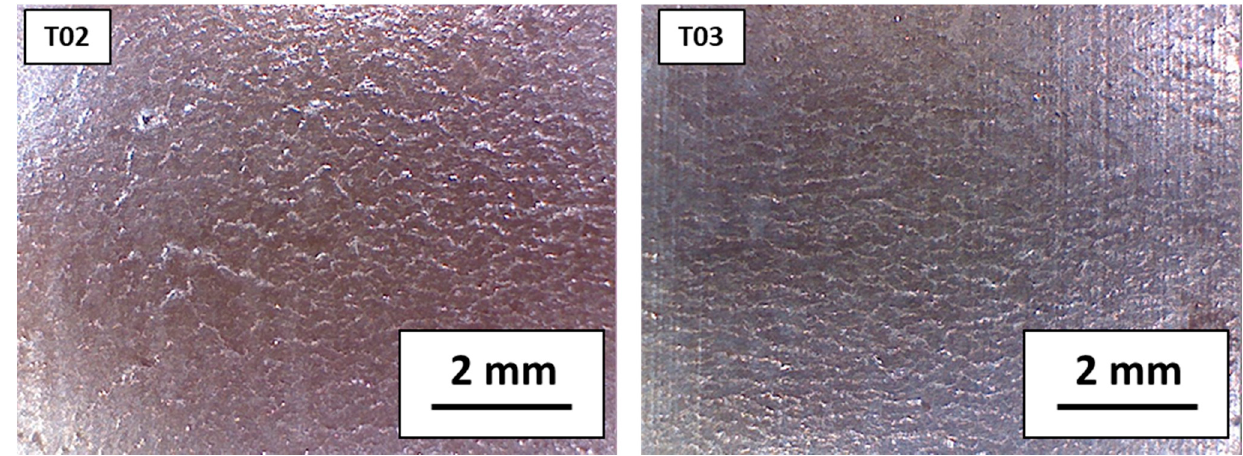
Figure 4. Running surfaces of the wheel discs at the end of the training tests ( T02 ) and ( T03 ).